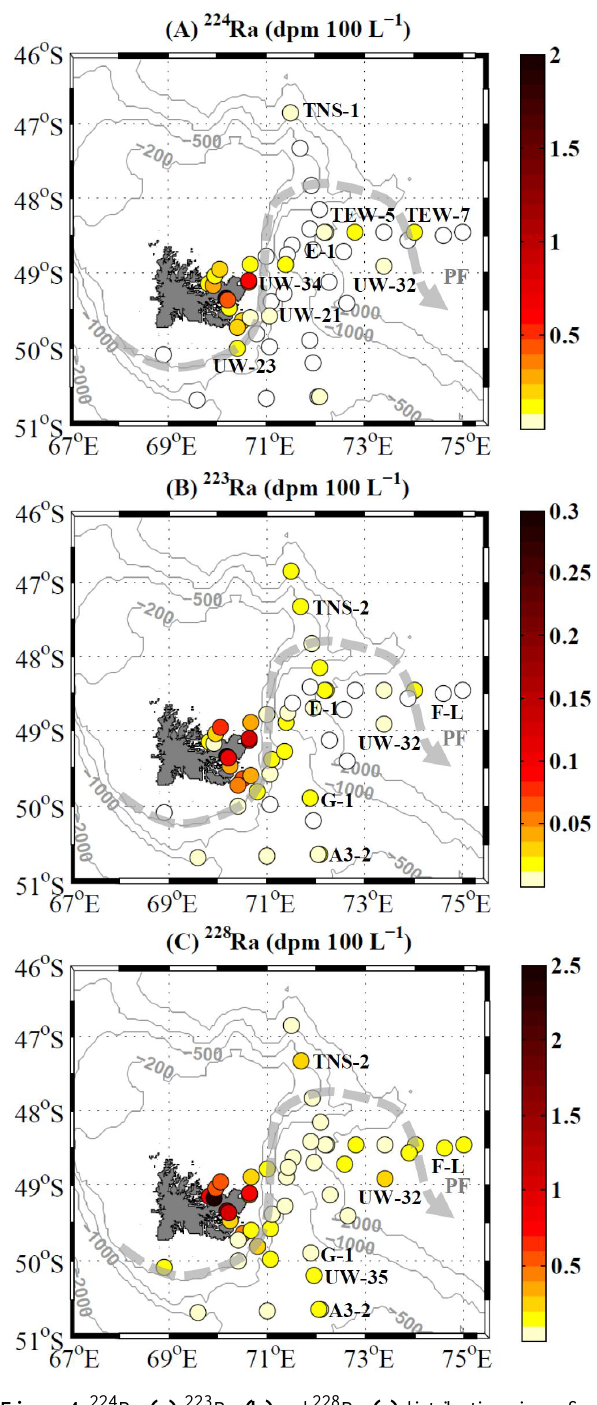
Figure 4. 224 Ra (a) , 223 Ra (b) and 228 Ra (c) distributions in surface waters off the Kerguelen Islands. Radium activities are expressed in dpm100L − 1 . White circles indicate samples with Ra activity below the detection limit. A schematic view of the polar front (PF) is